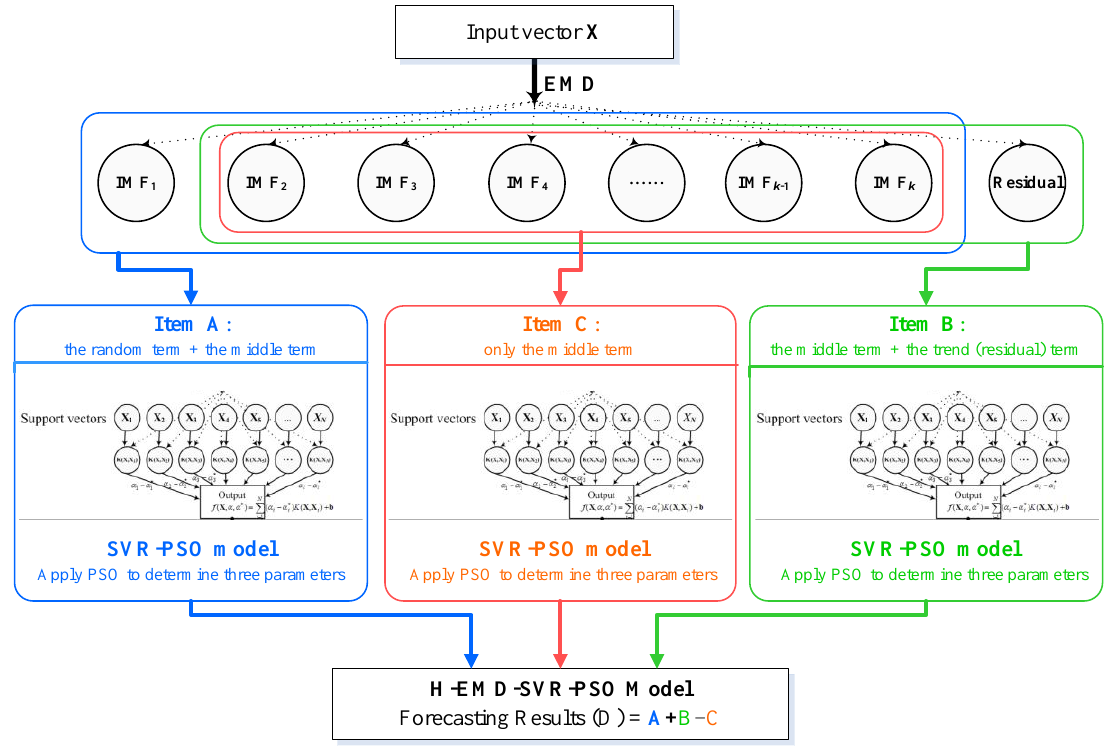
Figure 1. The full flowchart of the proposed H-EMD-SVR-PSO model.